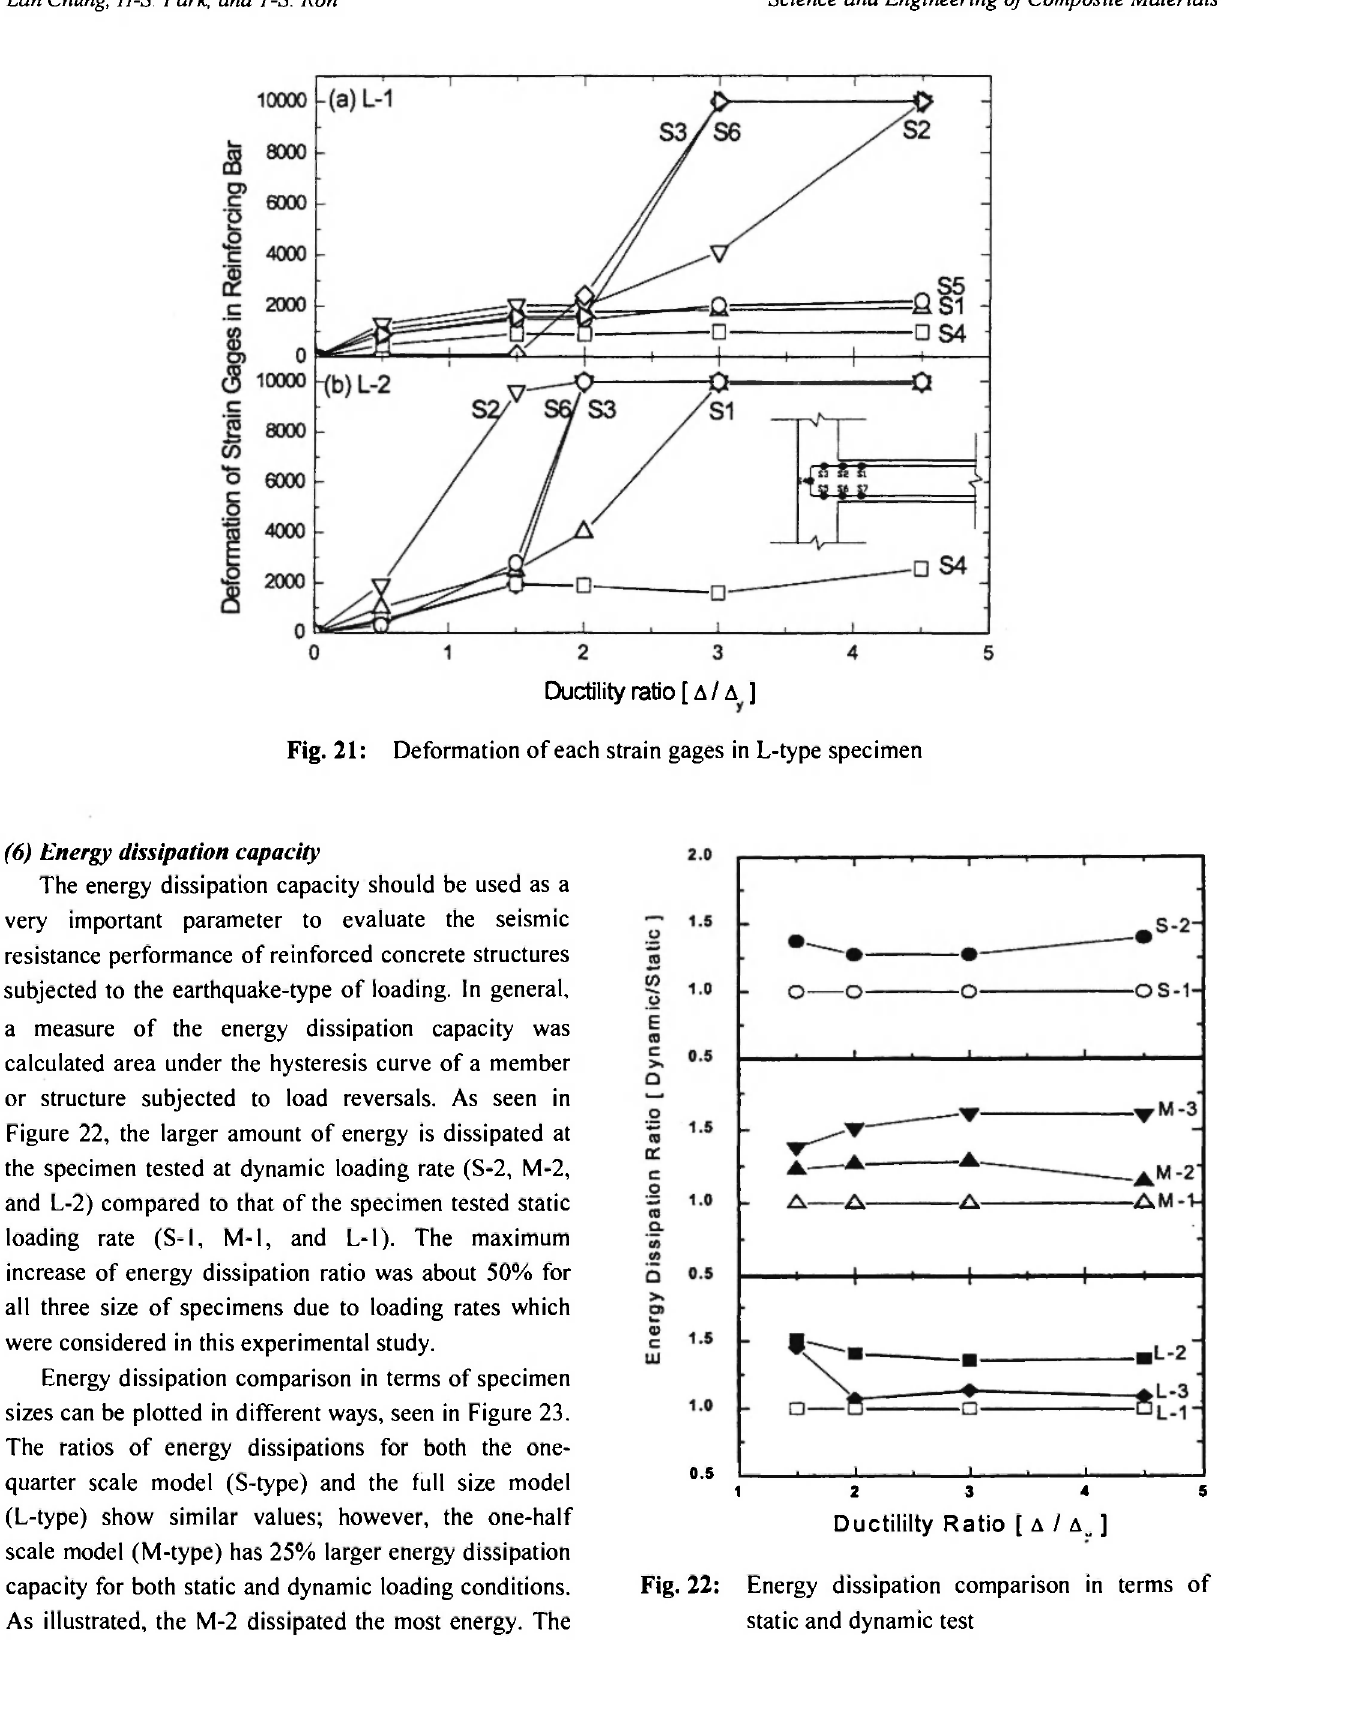
Fig. 22: Energy dissipation comparison in terms of static and dynamic